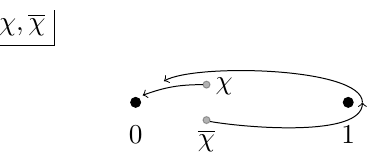
Figure 12. The paths of the cross ratios (cid:31); (cid:31) when moving from the Euclidean regime to the Regge regime. In the Euclidean regime, (cid:31); (cid:31) are complex conjugates (gray points). As we boost x 1 ; x 2 , the cross ratio (cid:31) decreases towards zero, while (cid:31) moves counterclockwise around 1 before decreasing towards zero. For su(cid:14)ciently large t , (cid:31) follows the same path as (cid:31) , but we have separated the paths to clarify the (cid:12)gure.